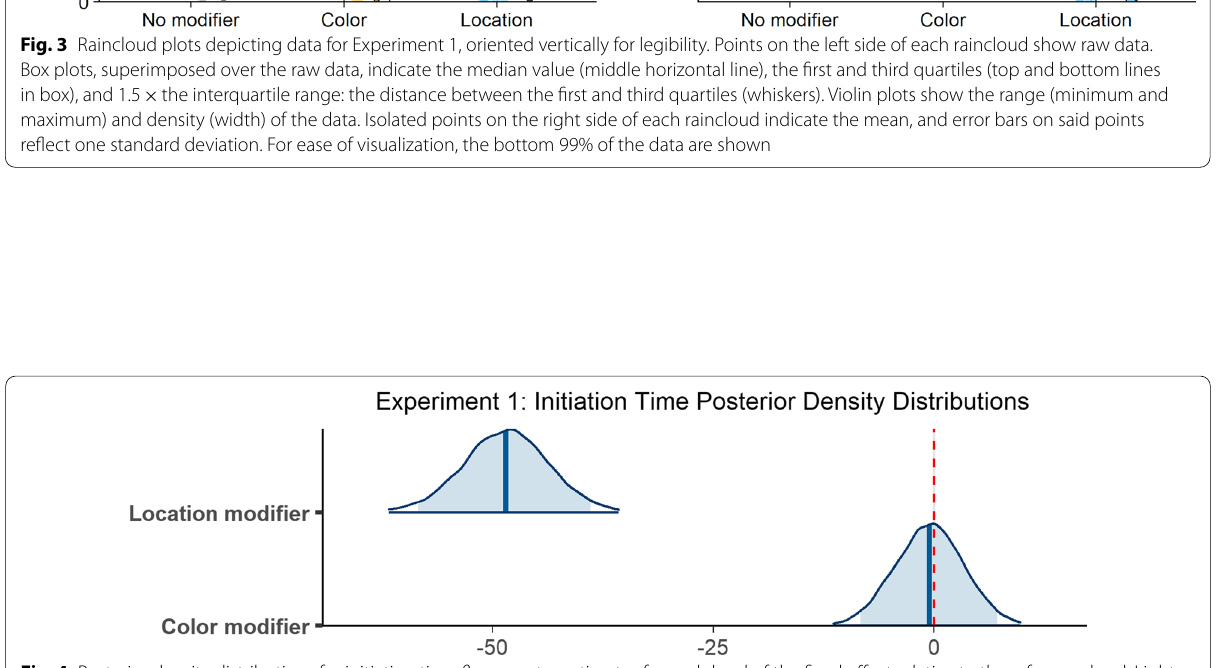
Fig. 4 Posterior density distributions for initiation time β parameter estimates for each level of the fixed effect relative to the reference level. Light blue shaded regions indicate the 95% credible interval and blue vertical lines indicate the mean of the distribution. The red vertical dashed line highlights 0 on the x axis. If the red line falls within the light blue shaded region, the estimate is not reliably different from zero and interpreted as a null